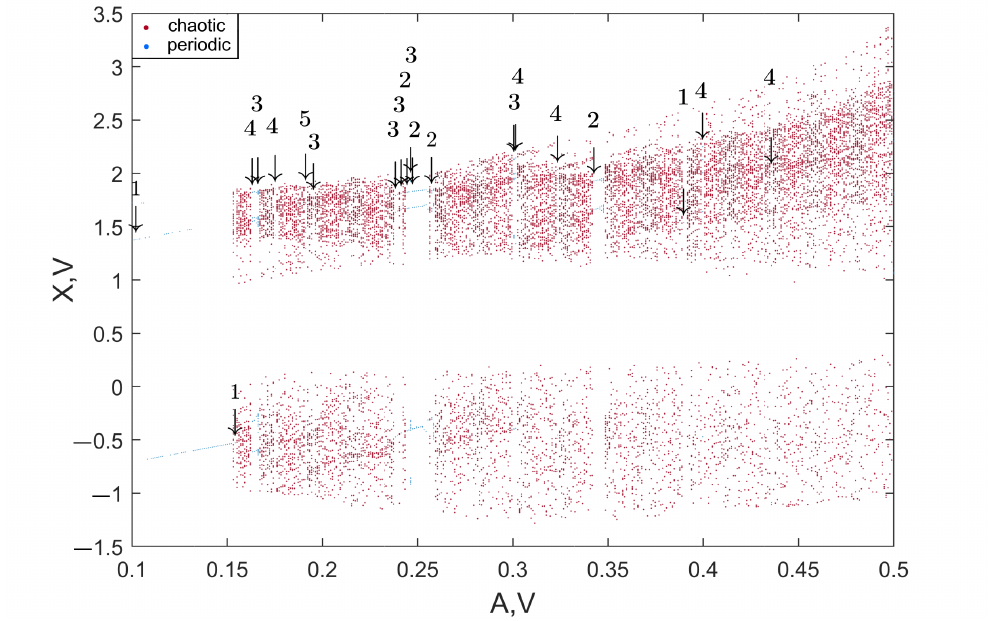
Figure 13. Bifurcation diagram of the Duffing oscillator at 1700 Hz sine wave input with variable amplitude with classified oscillation modes. The numbers indicate quantities of periodic